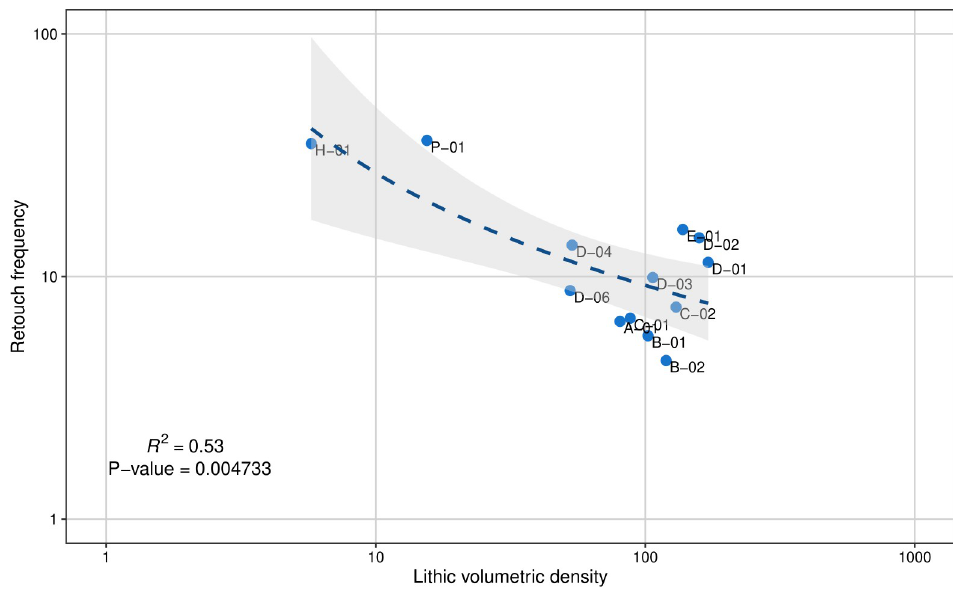
Fig 11. WABI graph for the various levels at Ganj